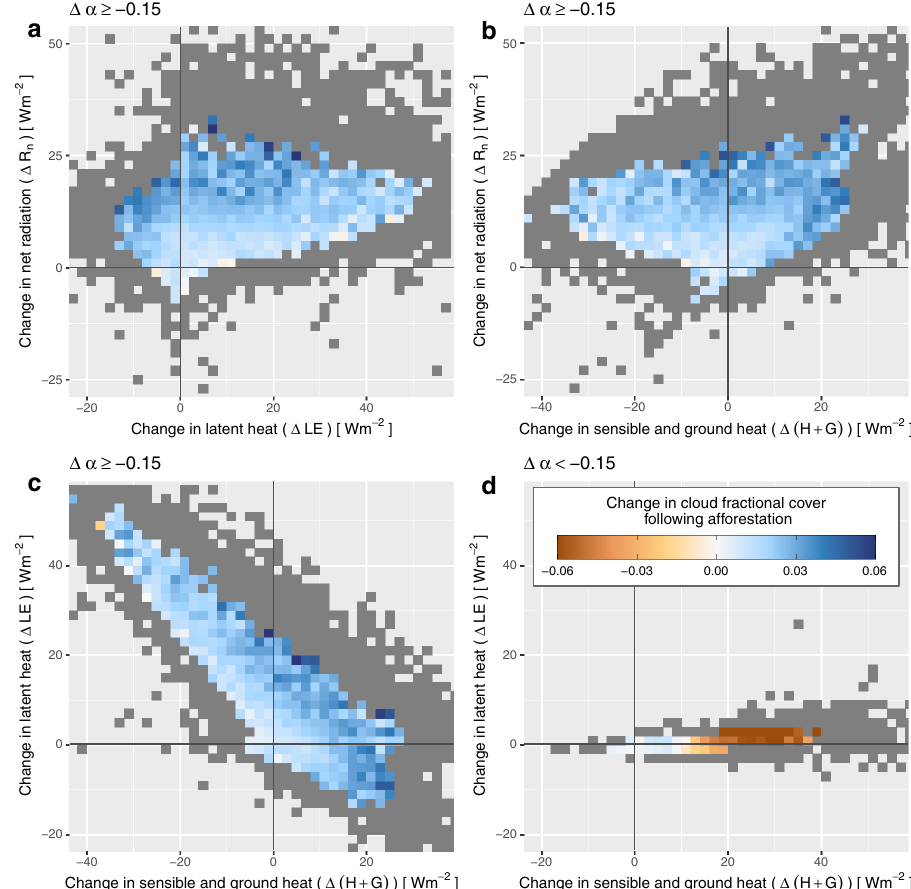
Fig. 7 Displaying the change in cloud fractional cover (CFrC) following potential afforestation with respect to associated estimated changes in components of the surface energy balance. All pixels at all seasons are combined together and each grid cell represents an average of underlying points. Grey cells contain less than 15 records and thus are considered non-representative. The dataset is separated between records unaffected by snow in ( a ), ( b ) and ( c ) (where Δ α ≥ − 0.15), and records in which there is a strong change in surface albedo due to snow ( Δ α < − 0.15) in ( d ). All data except for the changes in CFrC come from 76